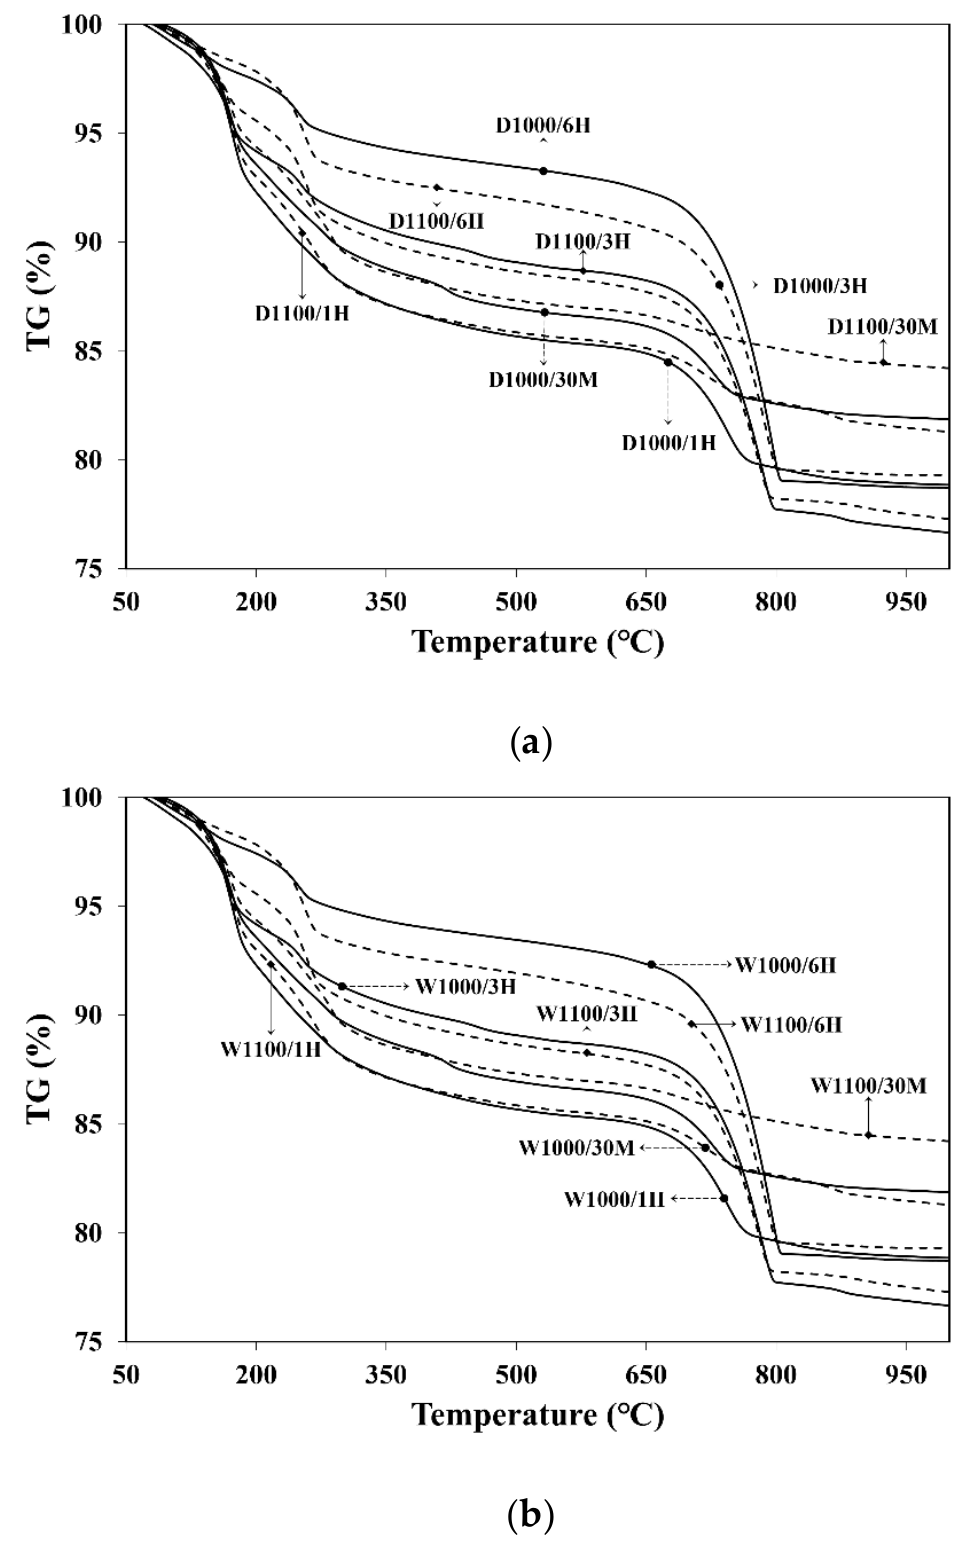
Figure 3. TGA carves of carbonation with ( a ) dry method and ( b ) wet method.